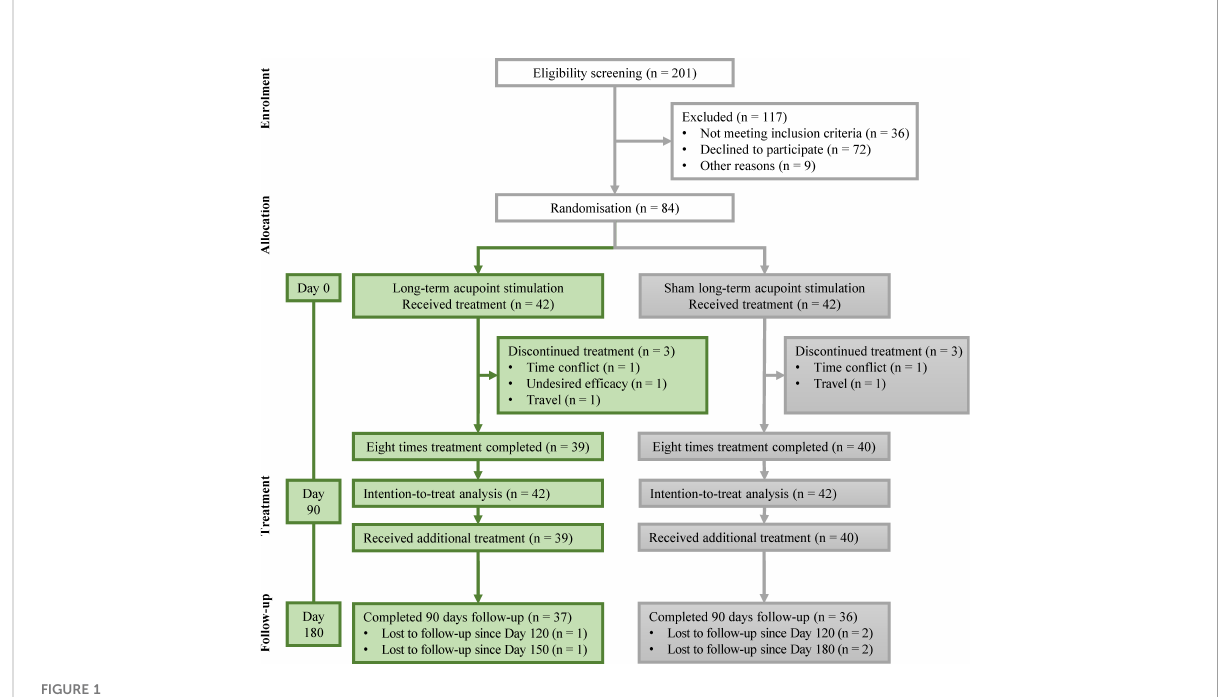
FIGURE 1 Participants ’ fl